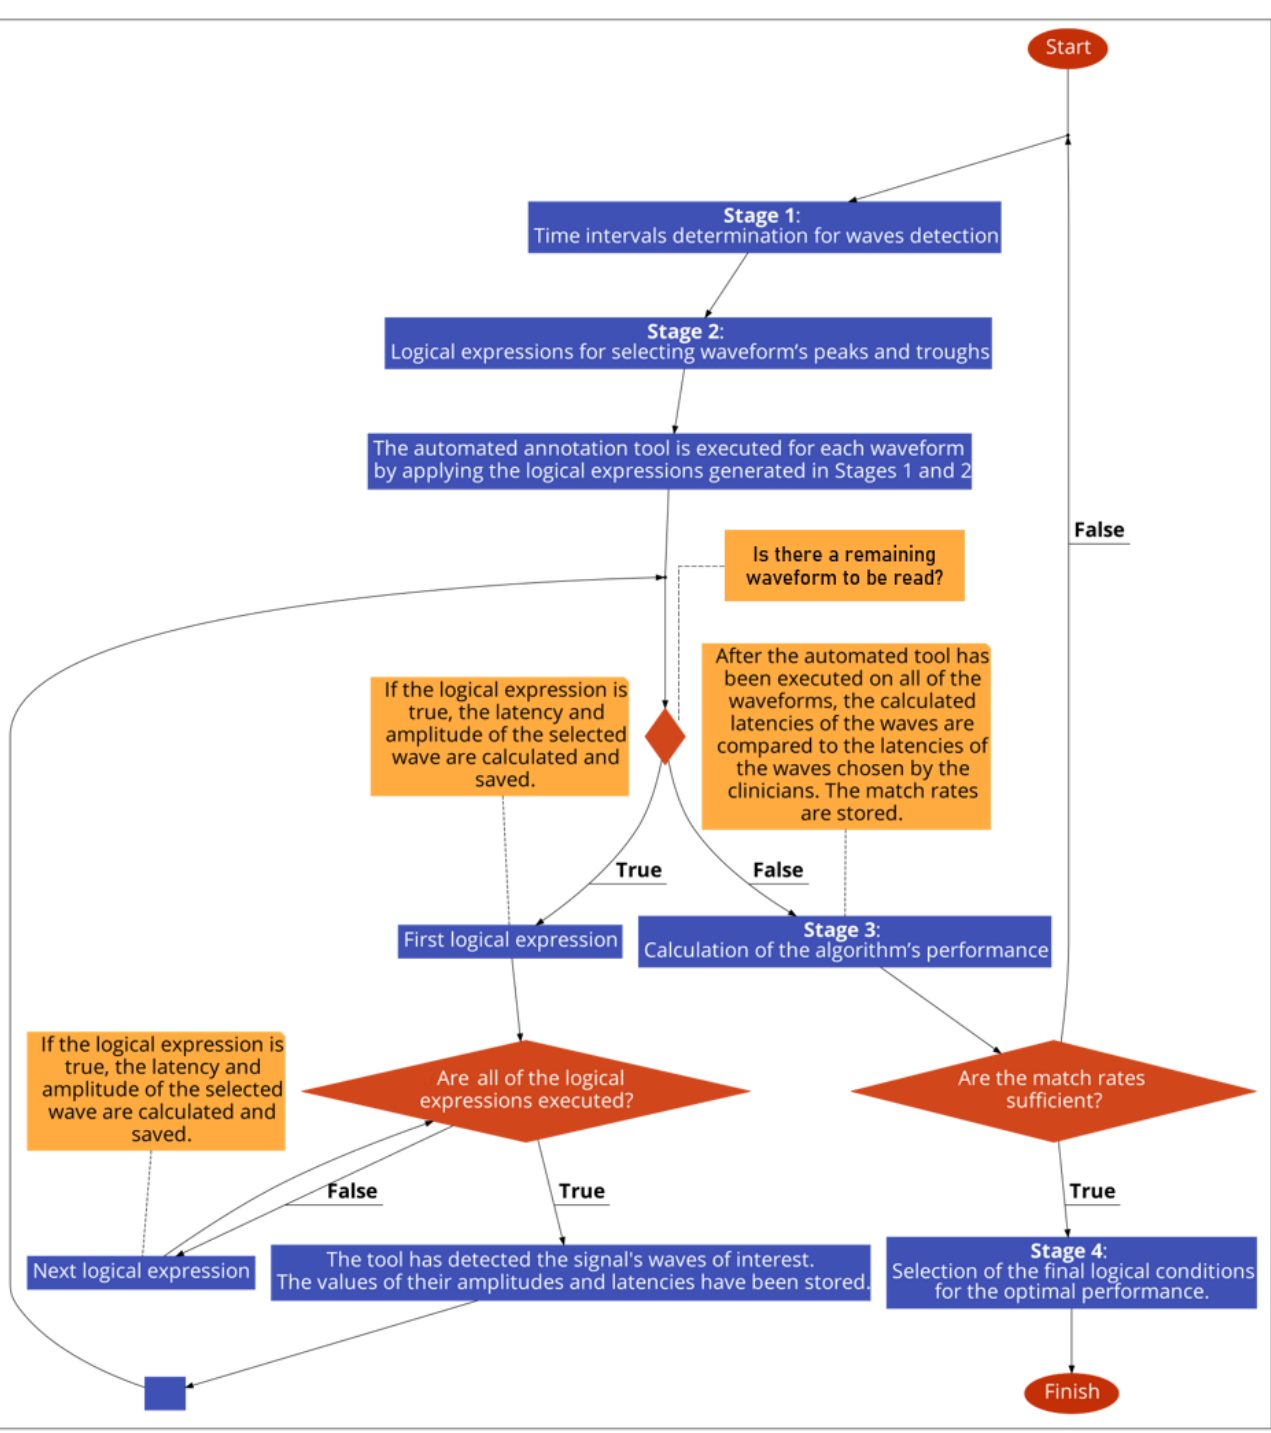
Figure 2. The development process of each automated annotation tool. Stage 2: logical expressions for selecting waveform’s peaks and Stage 1: time-interval determination for wave detection.